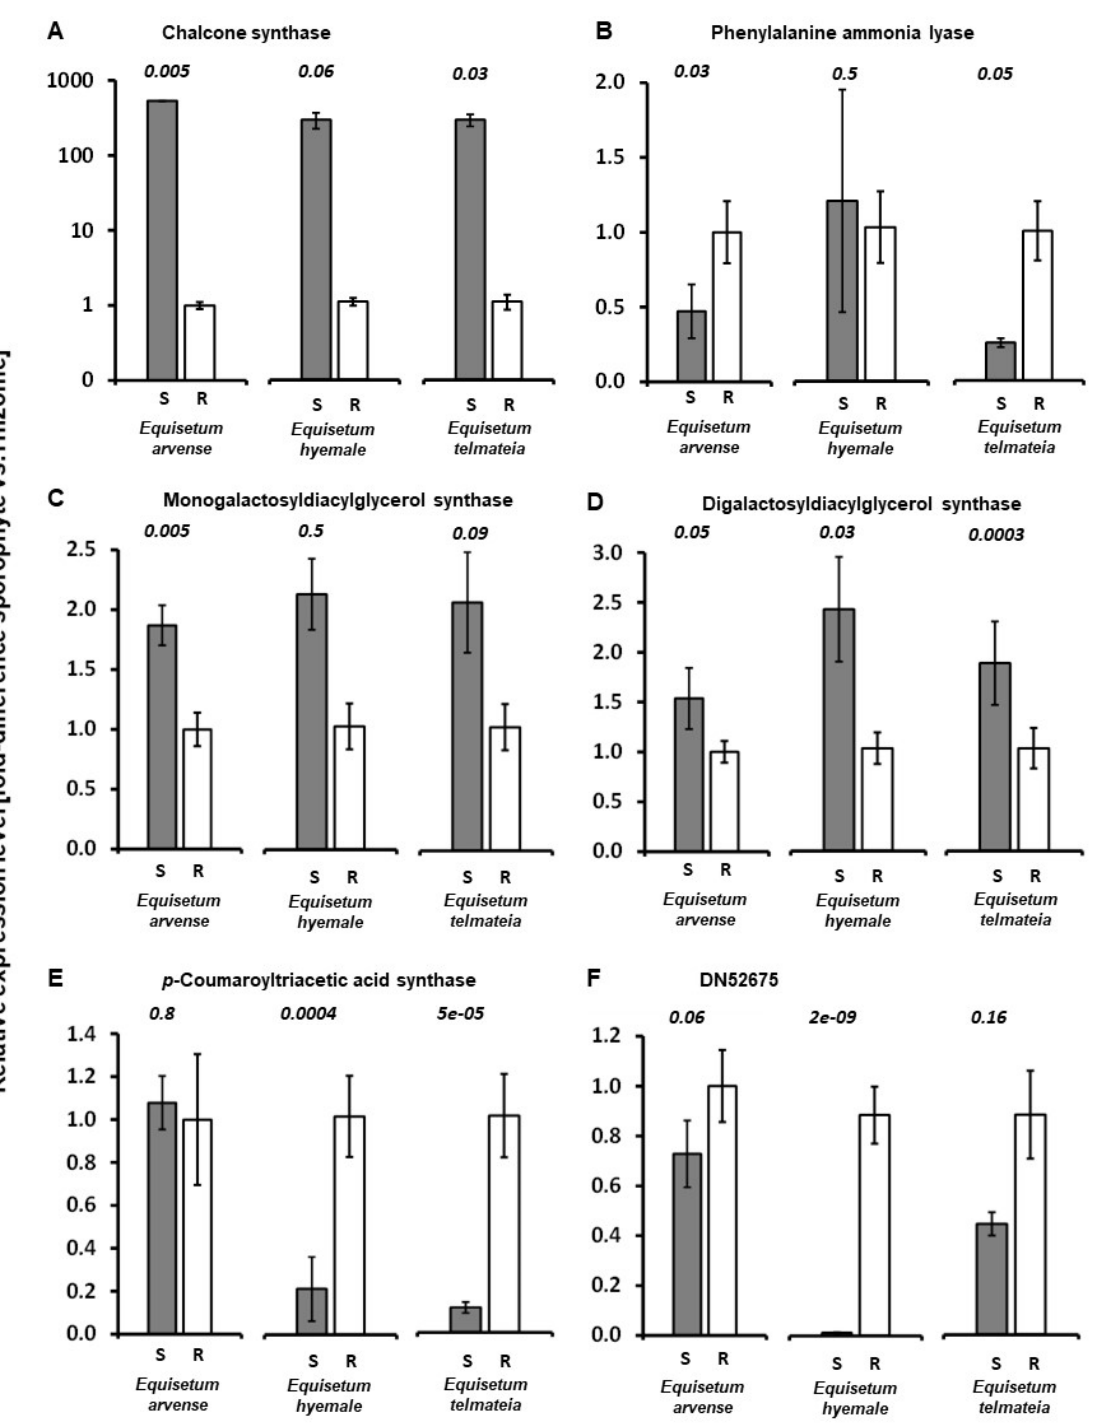
Figure 5. RT-qPCR analysis of expression patterns of selected genes (expressed as fold-change of shoot (gray column) versus rhizomes (white column); standard errors shown as bars): ( A ) chalcone synthase; ( B ) phenylalanine ammonia lyase; ( C ) monogalactosyldiacylglycerol synthase; ( D ) digalactosyldiacylglycerol synthase; ( E ) p -coumaroyltriacetic acid synthase; ( F ) transcript corresponding to the sequence of contig DN52675 (obtained during assembly of RNA-Seq data for E. telmateia rhizomes). Abbreviations: S, shoot; R, rhizome. The p -values obtained with a two-tiered Student’s t -test are shown in italics (comparison shoot versus rhizome for each species).